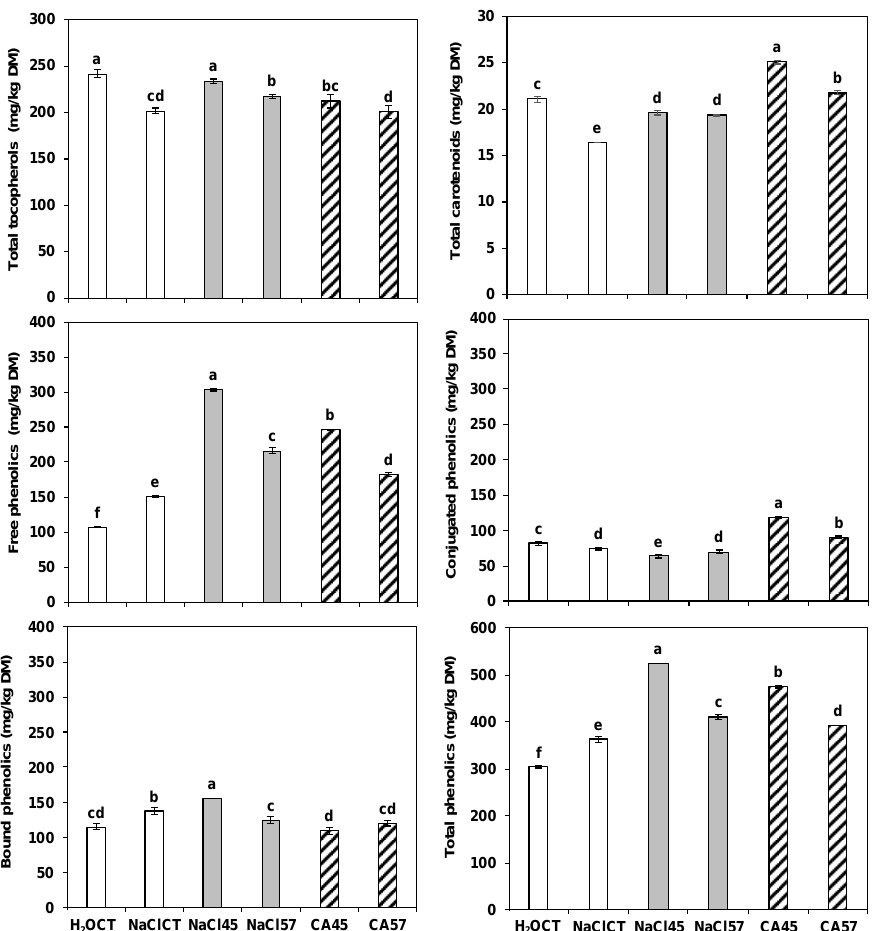
Figure 1. Total carotenoids, tocopherols, free phenolics, conjugated phenolics, bound phenolics, and overall phenolics of Lupinus albus seeds (Lot 2) debittered by the control methods with water (H 2 OCT; Erbaş [28]; Córdova-Ramos et al. [27]) or with NaCl solution (NaClCT; Villacrés et al. [31]), and by the debittering method proposed by Estivi et al. [25] using 1% NaCl solution (NaCl 45 and 57 h) or 1% citric acid solution (CA 45 and 57 h). The bars show the standard deviation, while the different letters indicate significant differences between samples according to the LSD test ( p ≤ 0.05). Overall, even after debittering, the lupin seeds preserved a significant content of phe- nolic compounds, which are positively correlated to the antioxidant capacity [17,29]. The citric acid solutions better preserved the conjugated phenols (especially using the shortest soaking time), while the NaCl solutions behaved poorly. The contrary was instead evident for the bound phenols; all of the samples that were treated with salt solutions (either by the control method or by the experimental protocol) showed significantly higher levels of insoluble-bound polyphenols (124.4 – 156.7 mg/kg DM) compared to the samples that were treated with the traditional method (115.3 mg/kg DM) or with citric acid (110.2 – 120.0